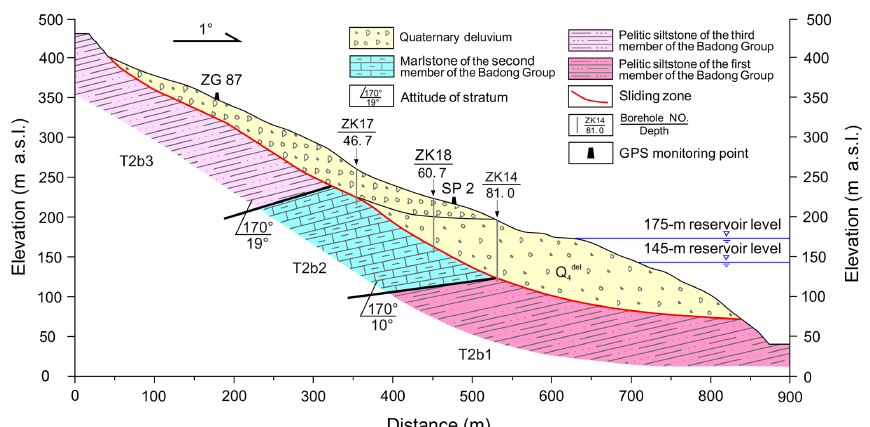
Figure 8. Geological profiles along section A–A’ as shown in Fig.